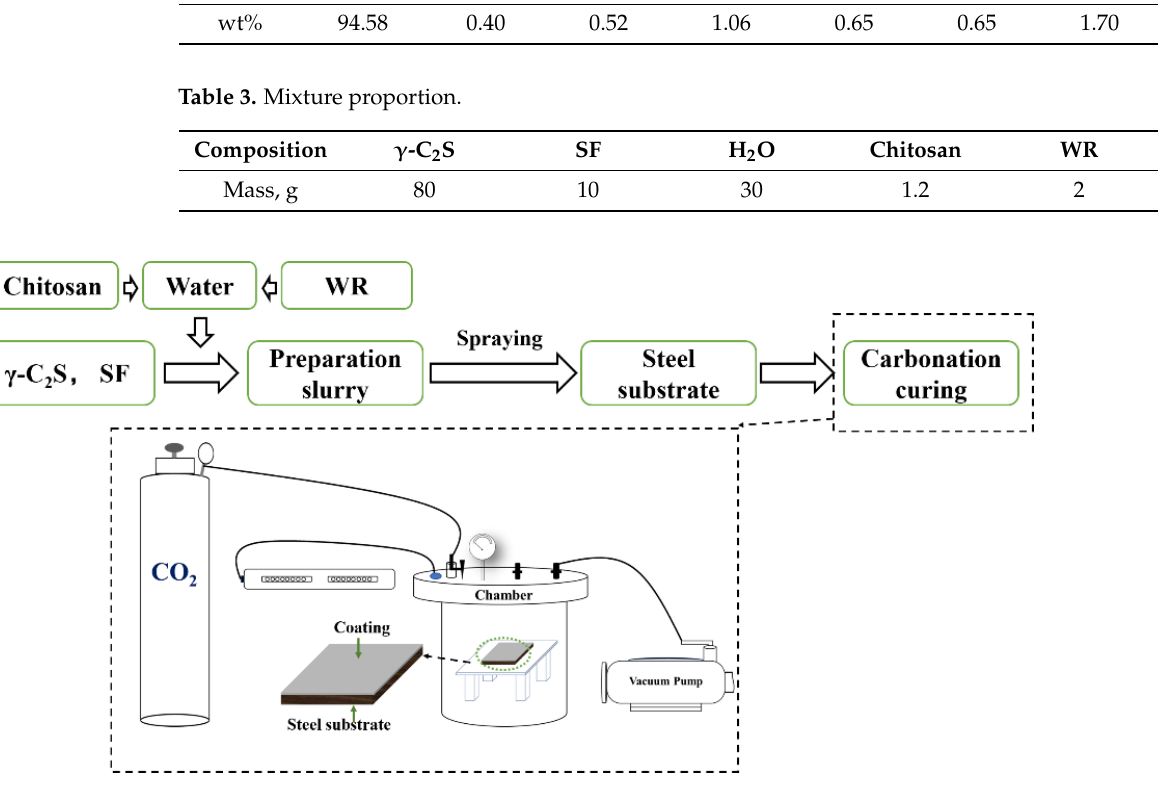
Figure 1. Schematic diagram of preparation process.